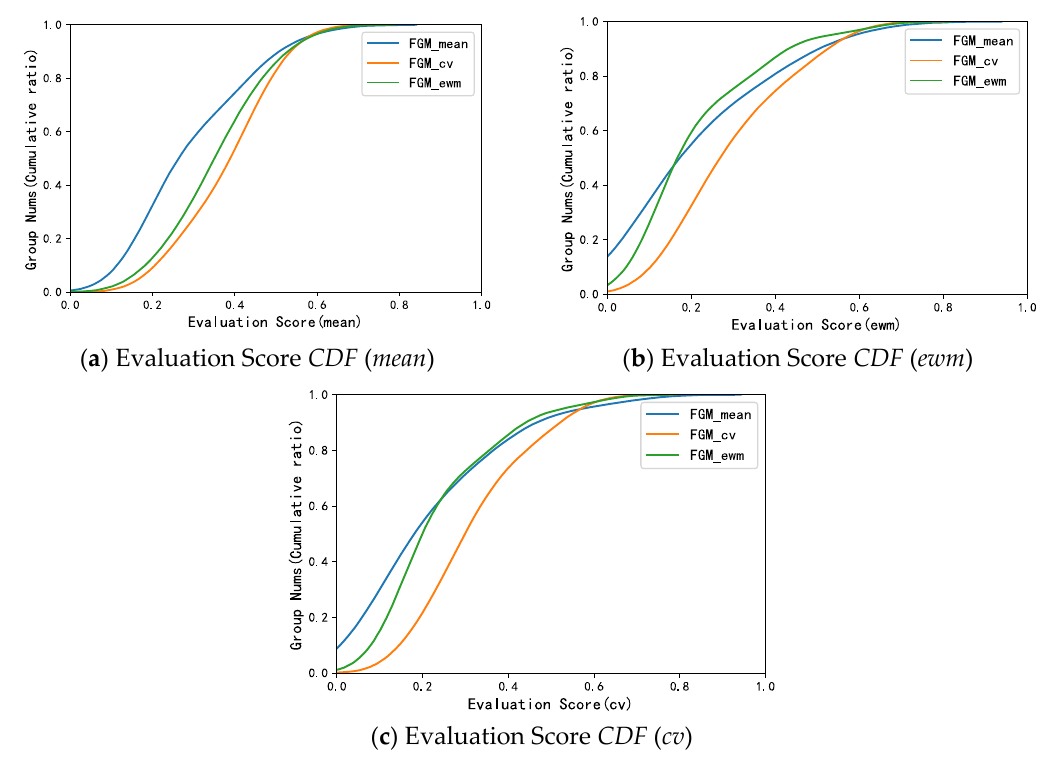
Figure 6. Metrics CDF Evaluation Results on Three Aggregation Methods